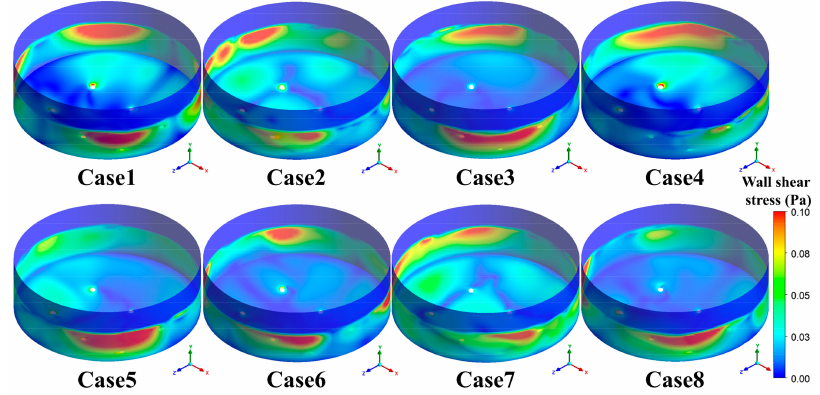
Figure 10. Wall shear stress contour in the eight cases.